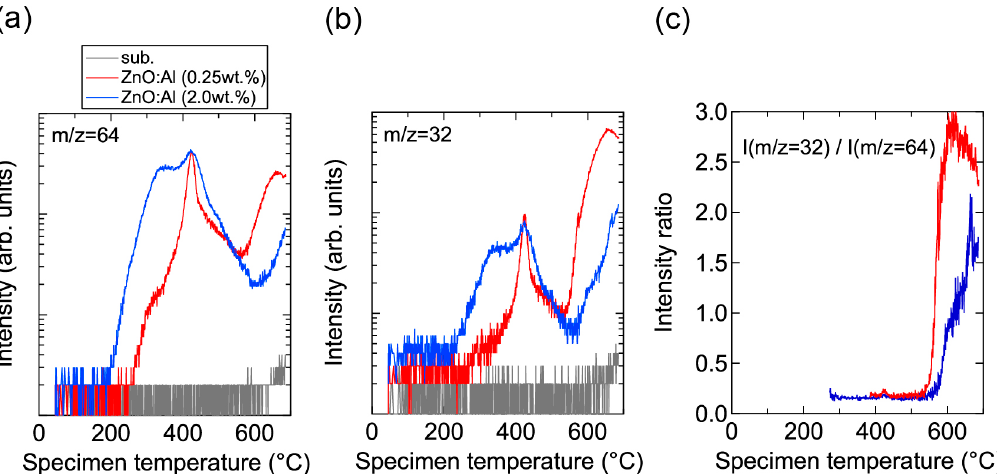
Figure 14. TDS spectra of desorption species with masses (m/z) of ( a ) 64 and ( b ) 32 from ZnO:Al (0.25 wt %) and ZnO:Al (2.0 wt %) films grown at optimized temperatures; ( c ) The intensity ratio of m/z = 32 to m/z = 64.